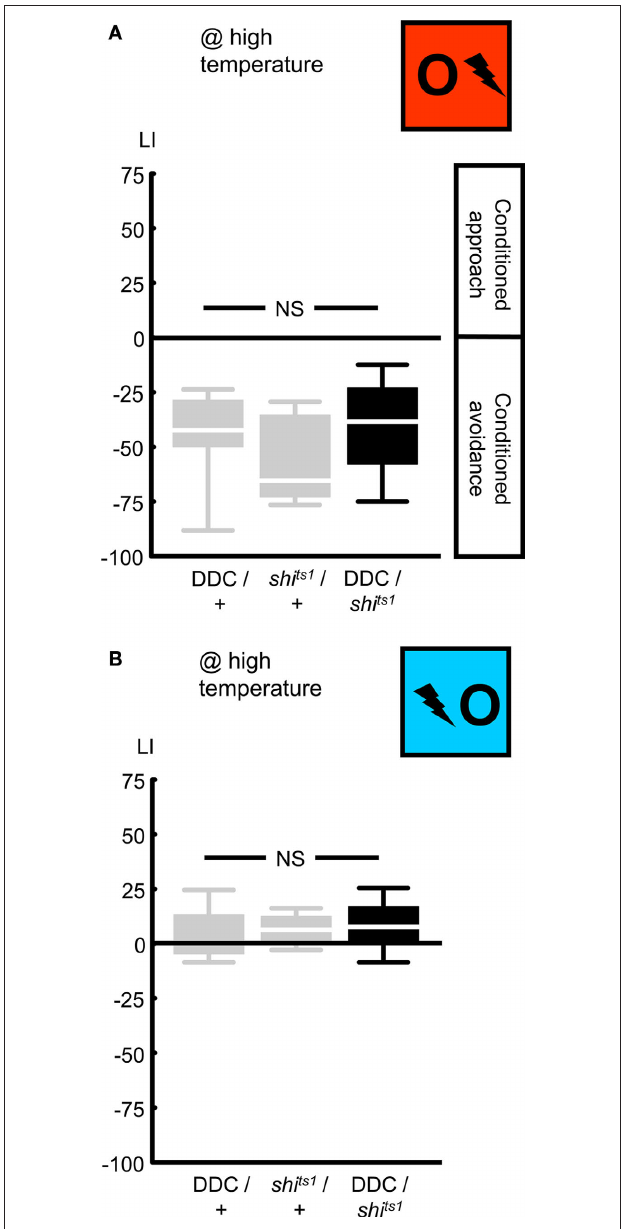
FiGuRe 5 | Targeting a set of dopaminergic/serotonergic neurons, using the DDC-Gal4 driver. We expressed shibire ts1 in the set of dopaminergic/ serotonergic neurons defined by the DDC-Gal4 driver. At high temperature, neither punishment learning (A) , nor relief learning (B) was affected. NS: P > 0.05, while comparing between genotypes. Sample sizes were from left to right N = 13, 11, 12 in (A) and 12, 11, 12 in (B) . Box plots are as detailed in Figure 4.